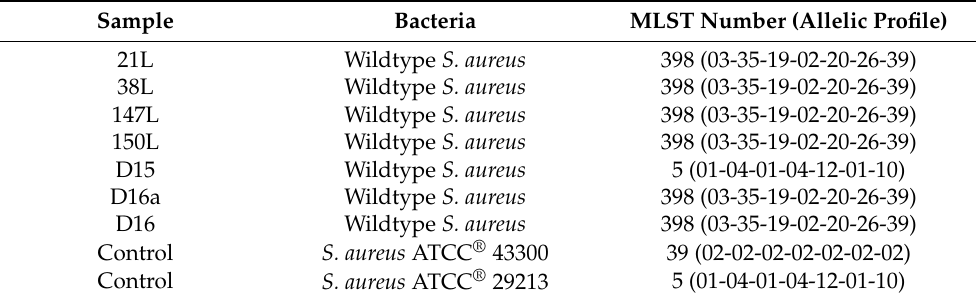
Table 3. Molecular typing of MRSA (methicillin-resistant Staphylococcus aureus ) strains isolated from swine mandibular lymph node tissue and commercial pork sausage